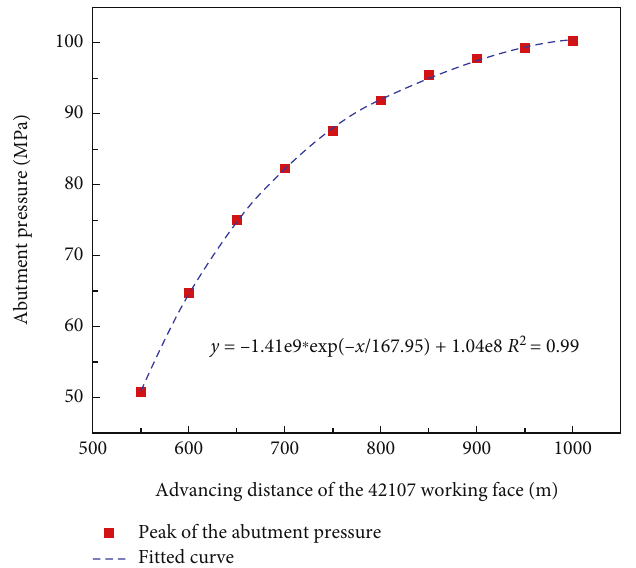
Figure 9: Relation between peak value of abutment pressure in the section coal pillar and mining distance of working face.